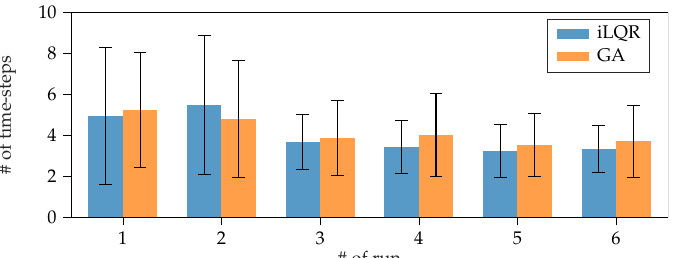
Figure 5. Statistical comparison of the number of steps required for the online iLQR and GA for the optimal working point attainment in FERMI. On average, the online iLQR performs the task in fewer steps.